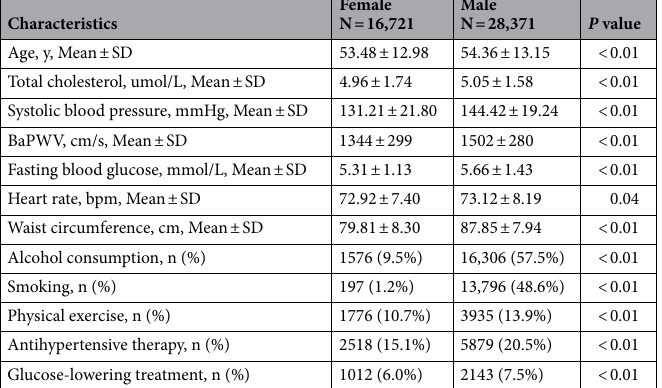
Table 1. Characteristics of the study population gender. BaPWV brachial-ankle pulse wave velocity, SD standard deviation.